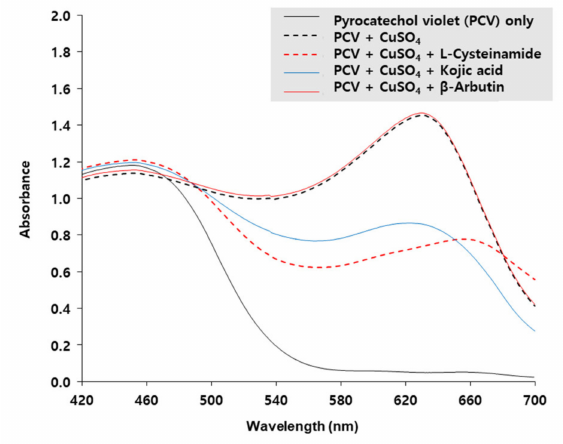
Figure 9. Copper-chelating activities of L-cysteinamide, kojic acid, and β -arbutin. Absorption spectra of 200 µ M pyrocatechol violet (PCV) reacted with 200 µ M CuSO 4 in the absence or presence of